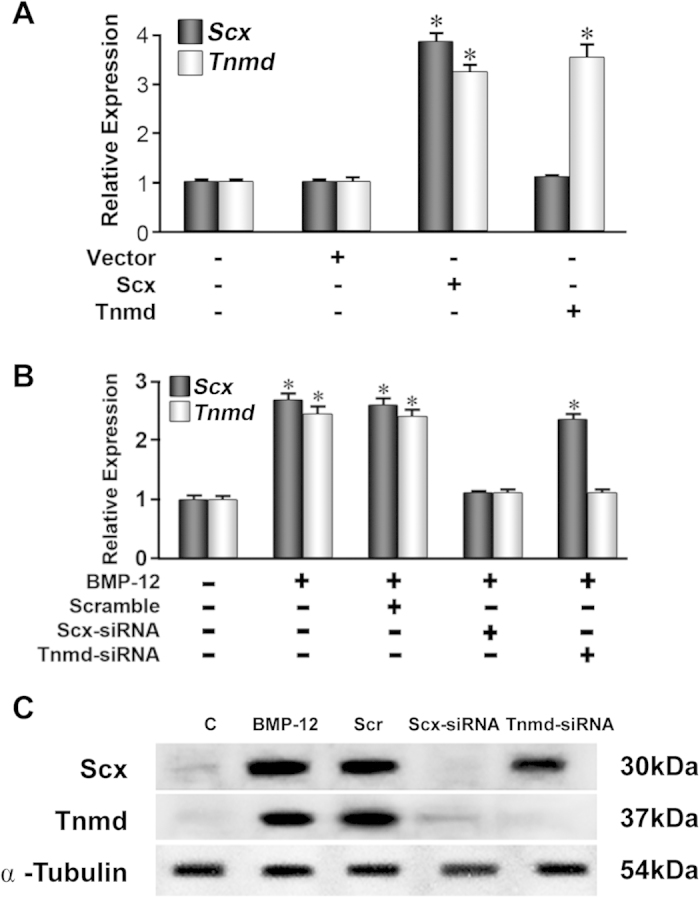
Scleraxis-dependent expression of tenomodulin in C3H10T1/2 cells.(A) Overexpression of Scx upregulated Tnmd. Cells were left untransfected or transiently transfected with empty vectors or vectors containing Scx or Tnmd cDNA. mRNA levels were determined by RT-qPCR. Data are expressed as mean ± S.D. (n = 3). *p < 0.01. (B,C) Knockdown of Scx blocked BMP-12-induced Tnmd. C3H10T1/2 cells untransfected or transfected with scramble siRNA, or Scx siRNA, or Tnmd siRNA were left untreated or stimulated with BMP-12, and mRNA and protein levels of gene expression were determined by RT-qPCR and Western blot, respectively. Data in (B) are expressed as mean ± S.D. (n = 6). *p < 0.05.